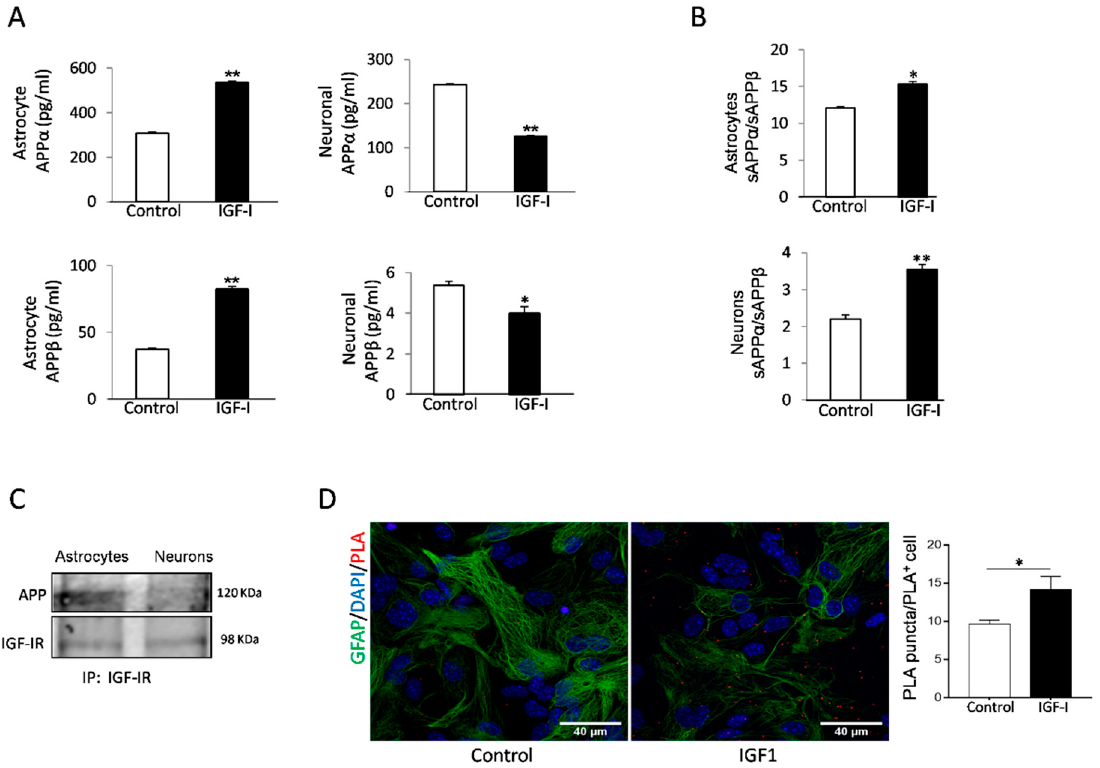
Figure 3. A β precursor protein (APP) processing in astrocytes is modulated by IGF-I. ( A ) IGF-I stimulated the secretion of both sAPP α and sAPP β in cultured astrocytes (left histograms) while inhibited it in neurons (right histograms, n = 4). ( B ) However, IGF-I increased the sAPP α /sAPP β ratio in both cell types, indicating a net non-amyloidogenic action of IGF-I in these cells. ( C ) IGF-IR and APP co-immunoprecipitate in cultured astrocytes, while in neurons, the interaction is negligible. ( D ) Proximity ligation assays (PLA) of APP and IGF-IR in cultured astrocytes confirm the interaction of both proteins that are upregulated by IGF-I ( n = 3). Cell nuclei stained with Hoescht. * p < 0.05 and ** p < 0.01.